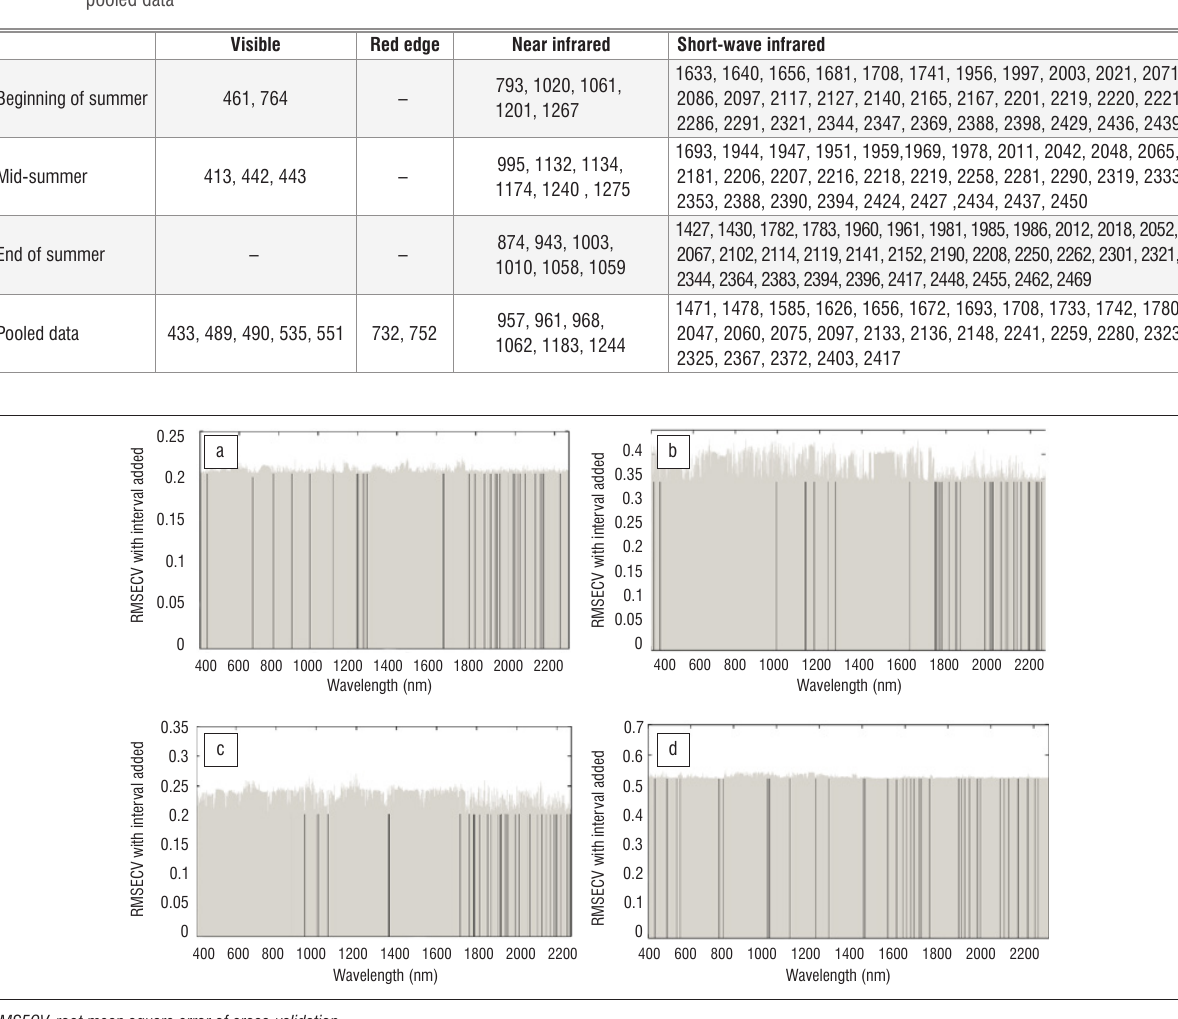
RMSECV, root mean square error of cross-validation Figure 4: Optimal bands (in dark bars) selected by interval partial least square regression in developing leaf area index models at the (a) beginning of, (b) mid- and (c) end of summer and (d) pooled